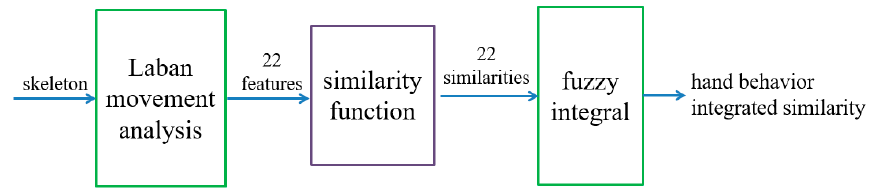
Figure 6. Illustration of the hand behavior-identification algorithm.